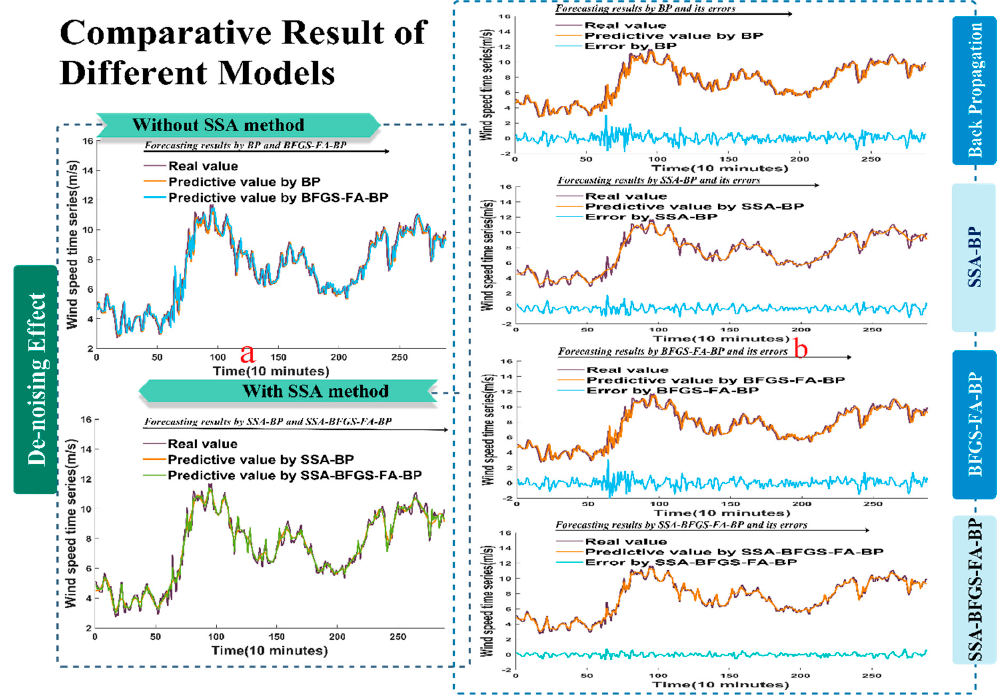
Figure 5. The forecast results for wind speed collected from site 2 at 10-min intervals. ( a ) The forecast effect without SSA algorithm and with SSA algorithm; ( b ) The comparison between the forecast values and the raw data and their corresponding errors.